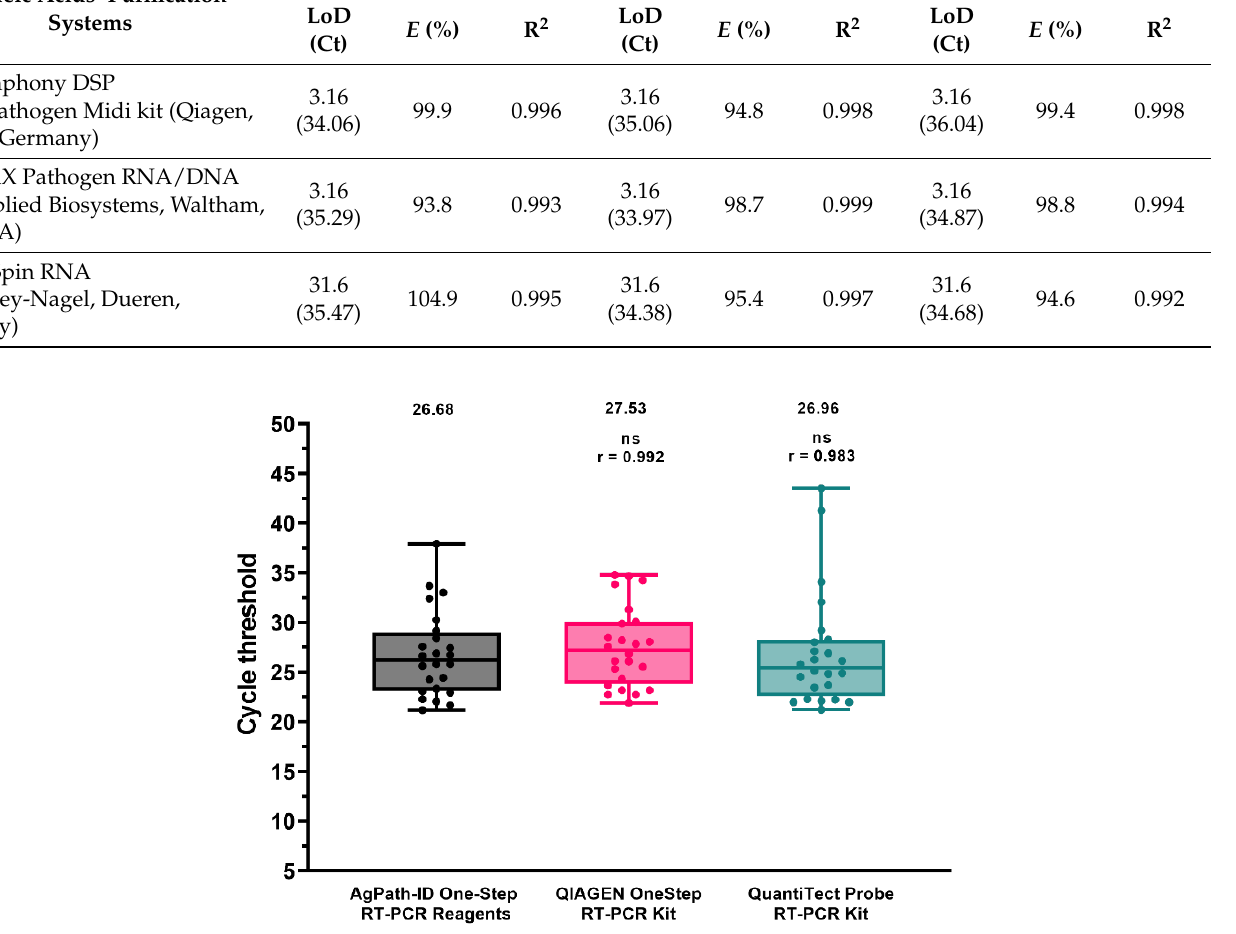
Figure 1. Performance comparison of different amplification kits. Dots represent individual Ct values. Mean Ct and Spearman’s rank correlation coefficient (r) are reported. ns: not significant.